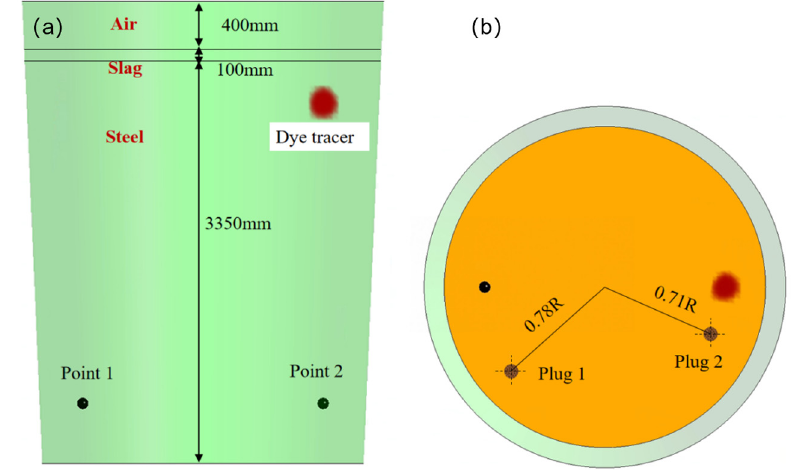
Figure 2. Geometry and boundary conditions for the full size model: ( a ) isometric view, ( b ) top view.